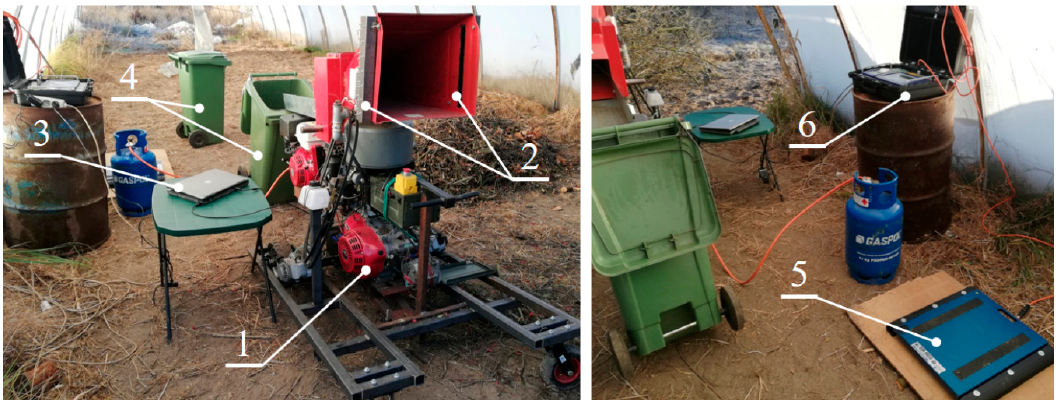
Figure 1. Woodchipper with measuring instruments; 1—woodchipper with engine drive, 2—sensors of branch detection system in the feeding chute, 3—recording computer, 4—120 L containers, 5—weighing scale, 6—weight recording system.